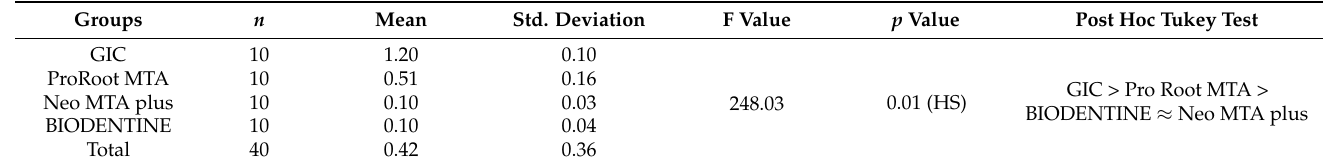
Table 2. Comparison of the sealing activity of different root end filling materials after 15 days ( n — total number of samples). Groups